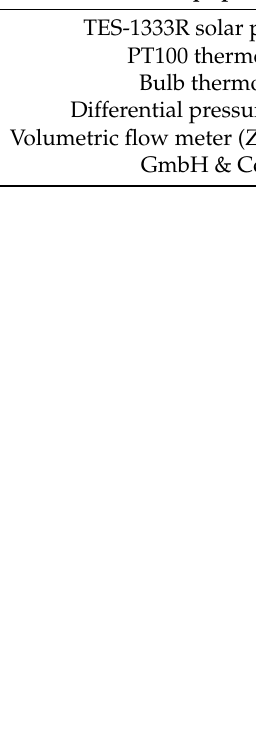
Table 2. The list of equipment for measurement and their accuracy.